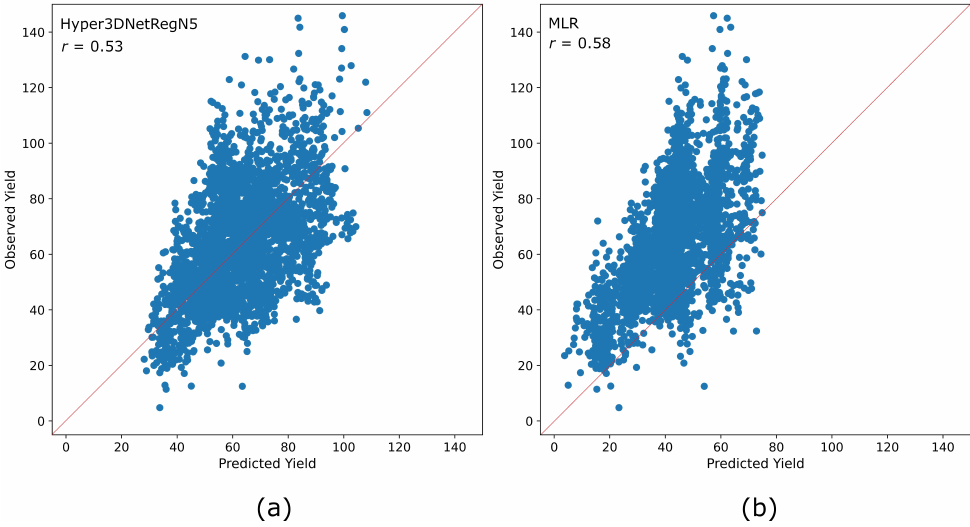
Figure 11. Predicted yield vs. observed yield plots obtained for the G3 field (Split B). ( a ) Results obtained by Hyper3DNetReg ( N = 5). ( b ) Results obtained by